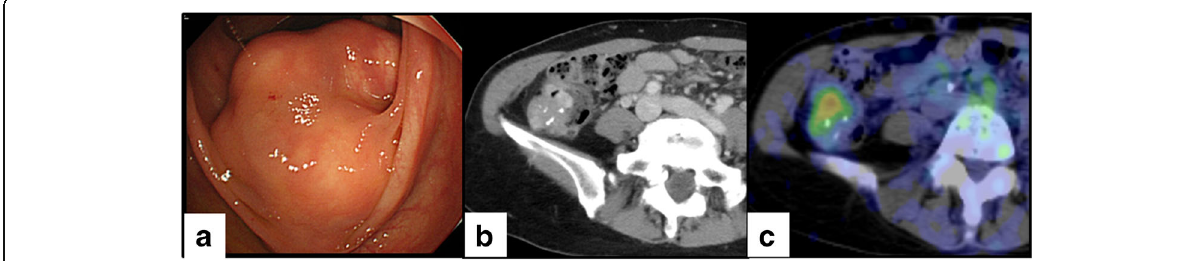
Fig. 1 Preoperative examinations. ( a ) A submucosal tumor extending from the liver flexure to the ascending colon was detected by colonoscopy. ( b ) Computed tomography showed irregular tumor edges and highly dense areas indicative of calcification. ( c ) The primary tumor standardized uptake value (SUV max ) of F-18 deoxyglucose was measured at 2.4 – 3.4 by positron emission